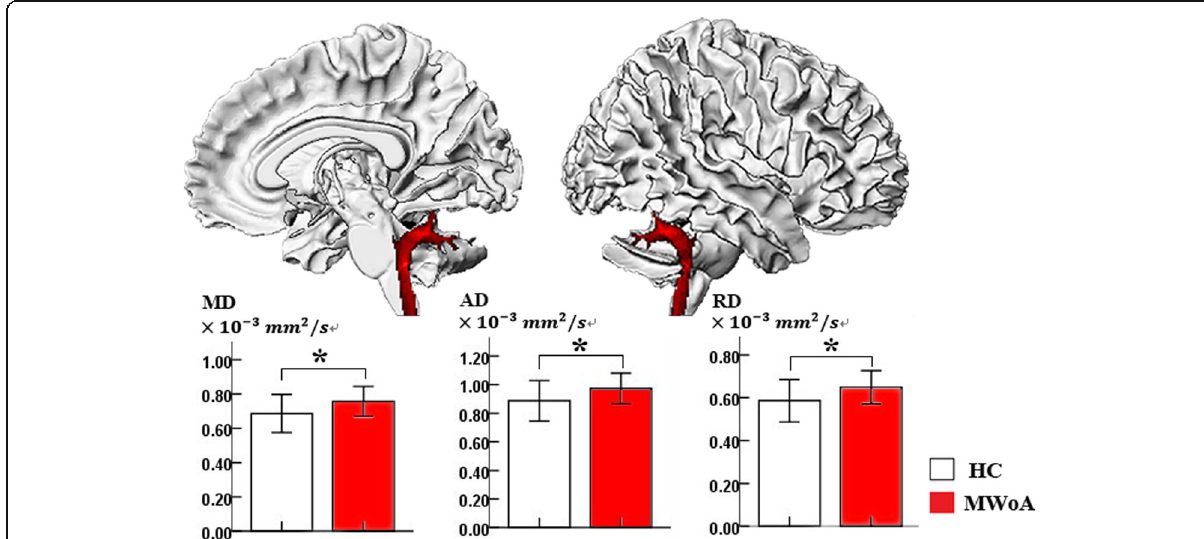
Fig. 2 Sagittal view of the right inferior cerebellar peduncle with significantly increased mean diffusivity (MD), axial diffusivity (AD), and radial